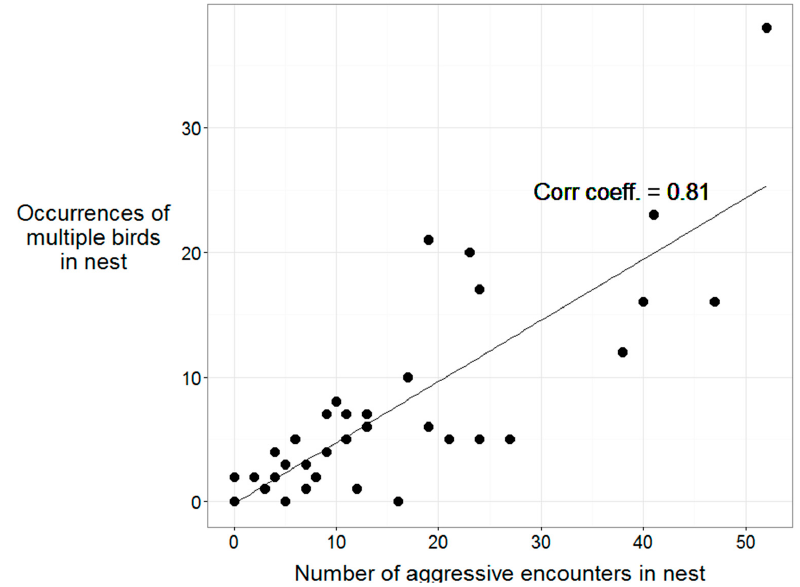
Figure 3. Correlation between the occurrences of multiple birds in the nest box and the number of aggressive encounters that occurred in nest boxes in all ducks that used nest boxes in the hour prior to oviposition site selection.